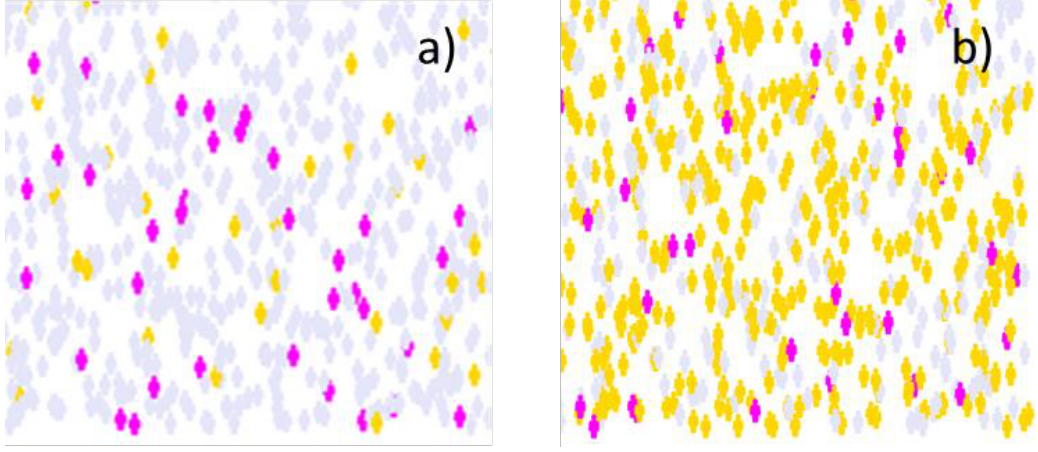
Figure 8: a) Start of model run. b) Changing of agents states.